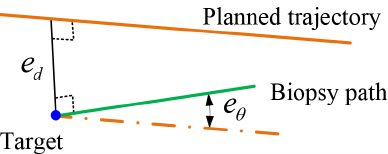
Figure 7. Metrics used to evaluate the accuracy including the angle e θ as well as the distance e d between two spatial lines.